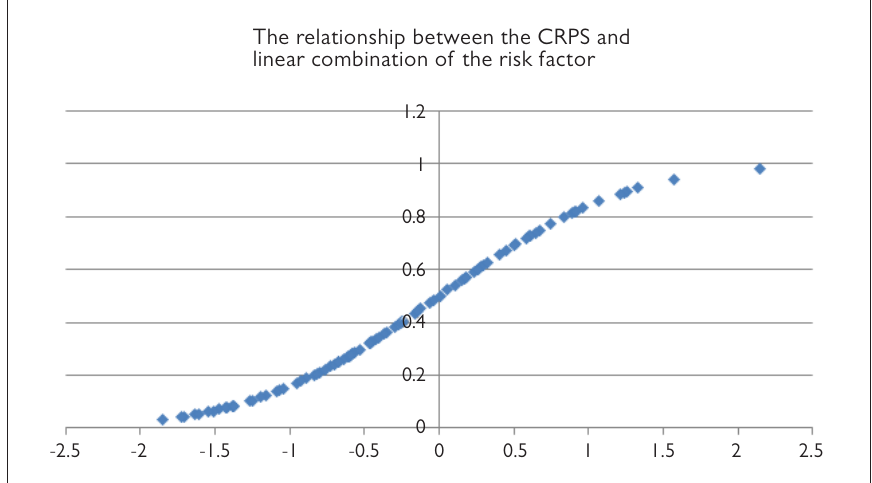
Figure 4. The relationship between CRPS and linear combination of the risk factors